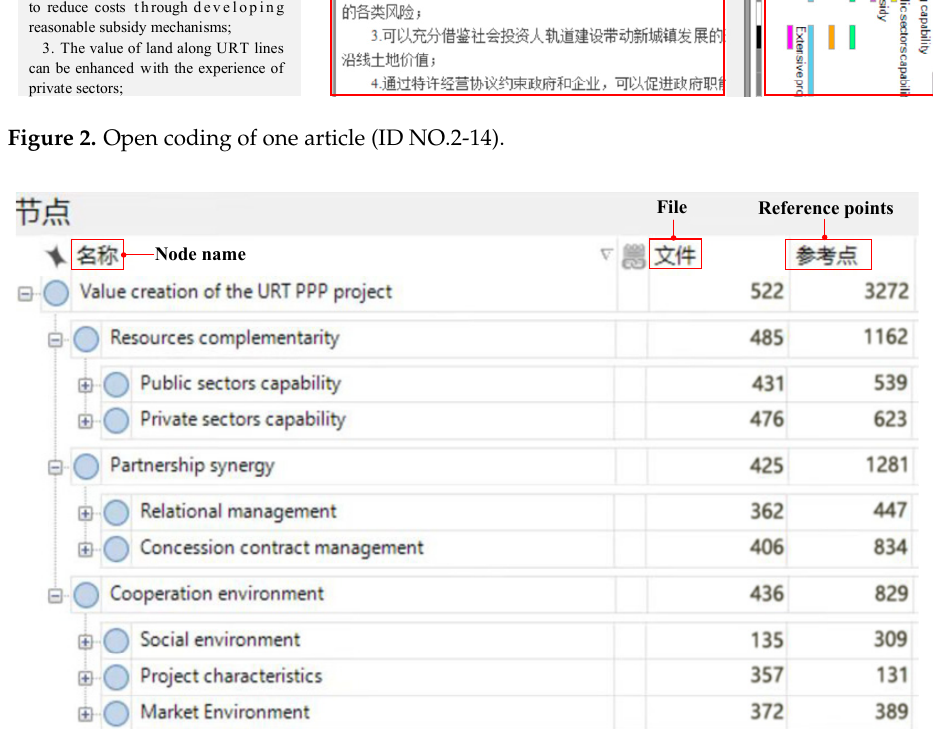
Figure 3. Axial coding process.